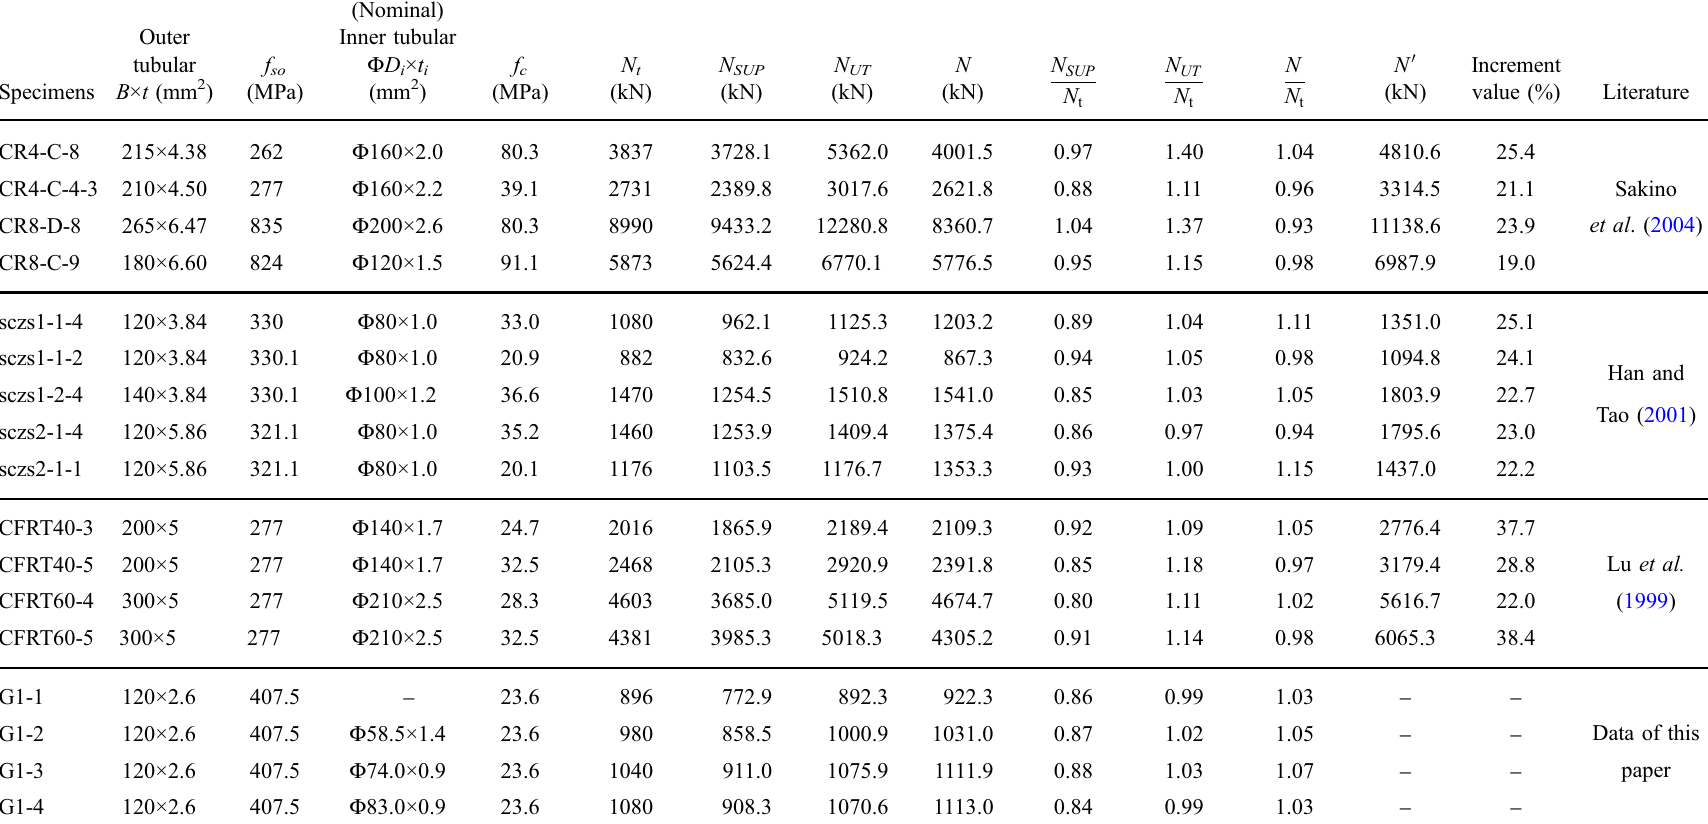
Table 3. Comparison of calculated and experimental results